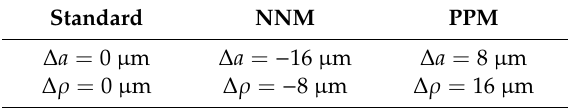
Table 3. Tooth profile modification (TPM) parameters of three cases for the example cycloid gear